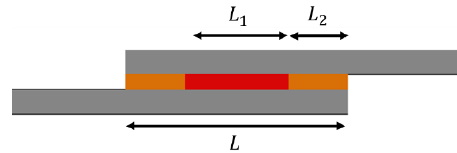
Figure 8. Mixed adhesive joint.